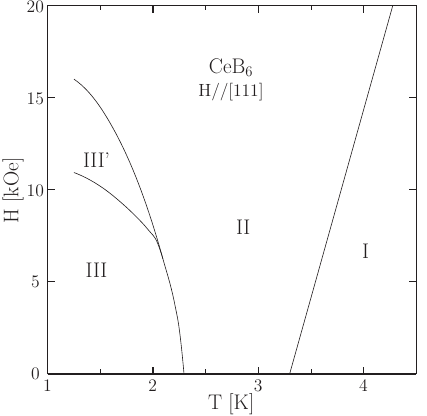
Figure 3. The low temperature H vs. T phase diagram for CeB 6 displays four phases. Phase I is the paramagnetic Kondo phase. Before the Kondo effect can compensate the internal degrees of freedom, there is a second order transition to the antiferro-quadrupolar phase (II) with the Q AFQ at the R point of the Brillouin zone. At lower T in the phases III and III’ antiferromagnetism kicks in. Phase diagram taken from Ref.